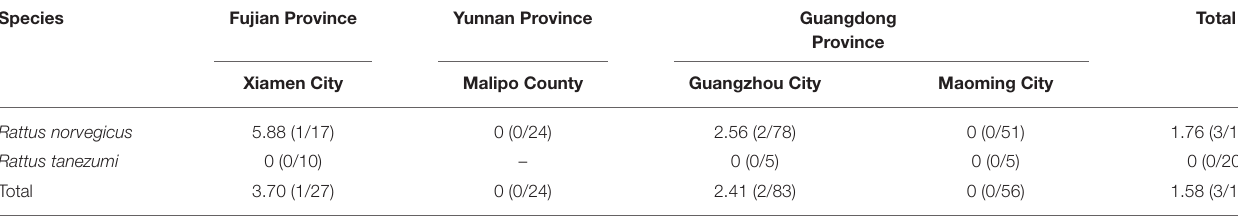
TABLE 2 | Detection of Seoul virus in serum samples from the trapped animals. Species